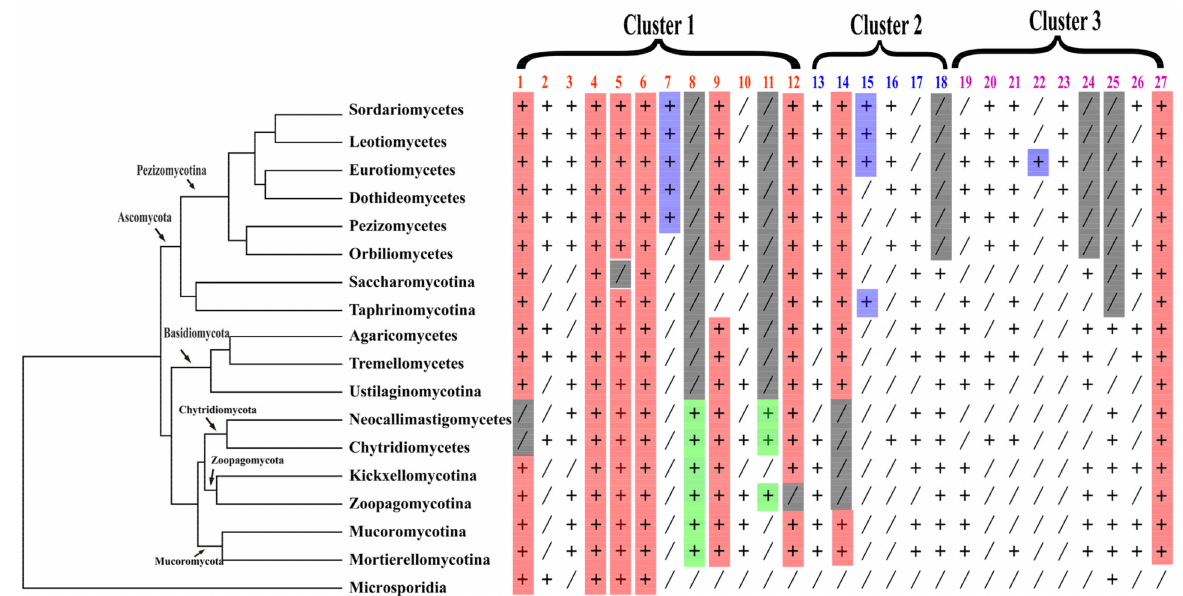
Figure 8. Diversification of SET-domain genes in fungi. Distribution pattern of SET genes in different fungal taxonomic groups. Those 3816 SET-domain genes from 229 fungal species can mainly be classified into three distinct clusters (Cluster 1, 2, and 3, respectively), and twelve, six, and nine groups can be observed in each of the three clusters. One representative is elected for each order. “Plus” indicates the presence of SET genes, and “Slash” indicates the absence of SET